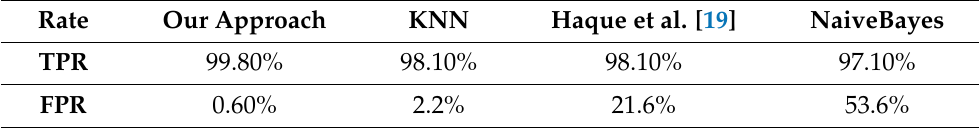
Figure 11. Proposed solution’s ROC curve. Table 2. TPR and FPR for each